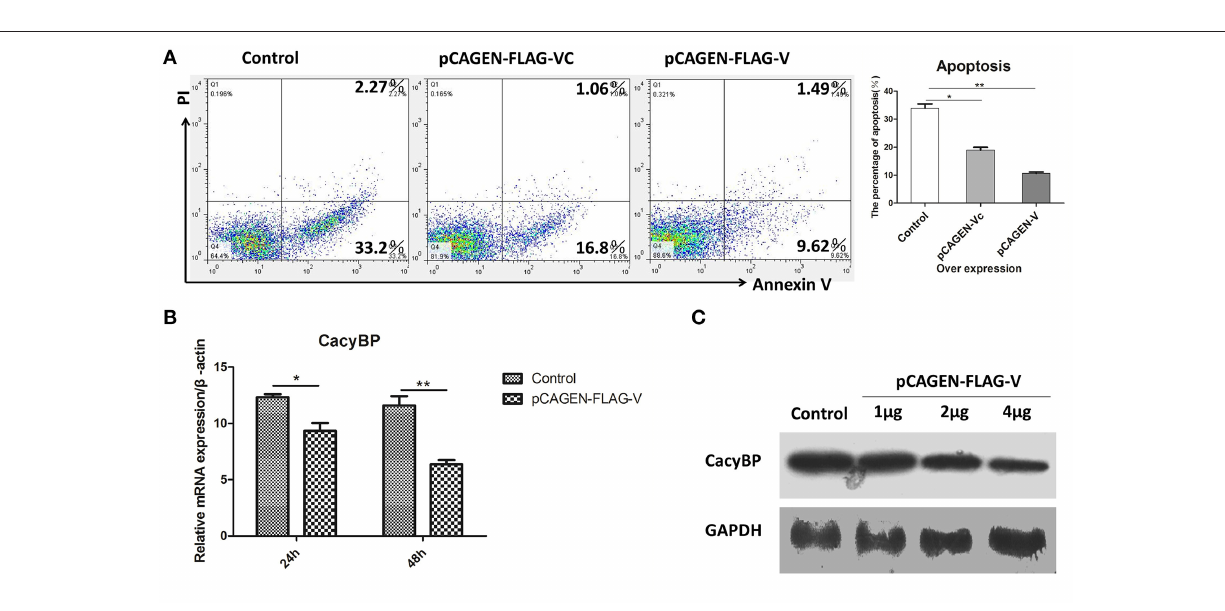
FIGURE 5 | V protein inhibited apoptosis by downregulating CacyBP in DF-1 cells. DF-1 cells were transfected with the control (pCAGEN-Flag), pCAGEN-Flag-VC, and pCAGEN-Flag-V. (A) The transfected cells were washed and harvested 48h after transfection, and flow cytometry was used to analyze cell apoptosis. (B) Twenty-four and forty-eight hours after transfection, the mRNA levels of CacyBP were measured by Q-PCR. (C) Protein expression of CacyBP was measured in DF-1 cells. The cells were transfected with pCAGEN-Flag (control) and pCAGEN-Flag-V (1, 2, and 4 µ g), and after 48h, the cells were harvested and analyzed by western blotting. Data shown in (A,B) are mean ± SD of three independent experiments. * P < 0.05; ** P <